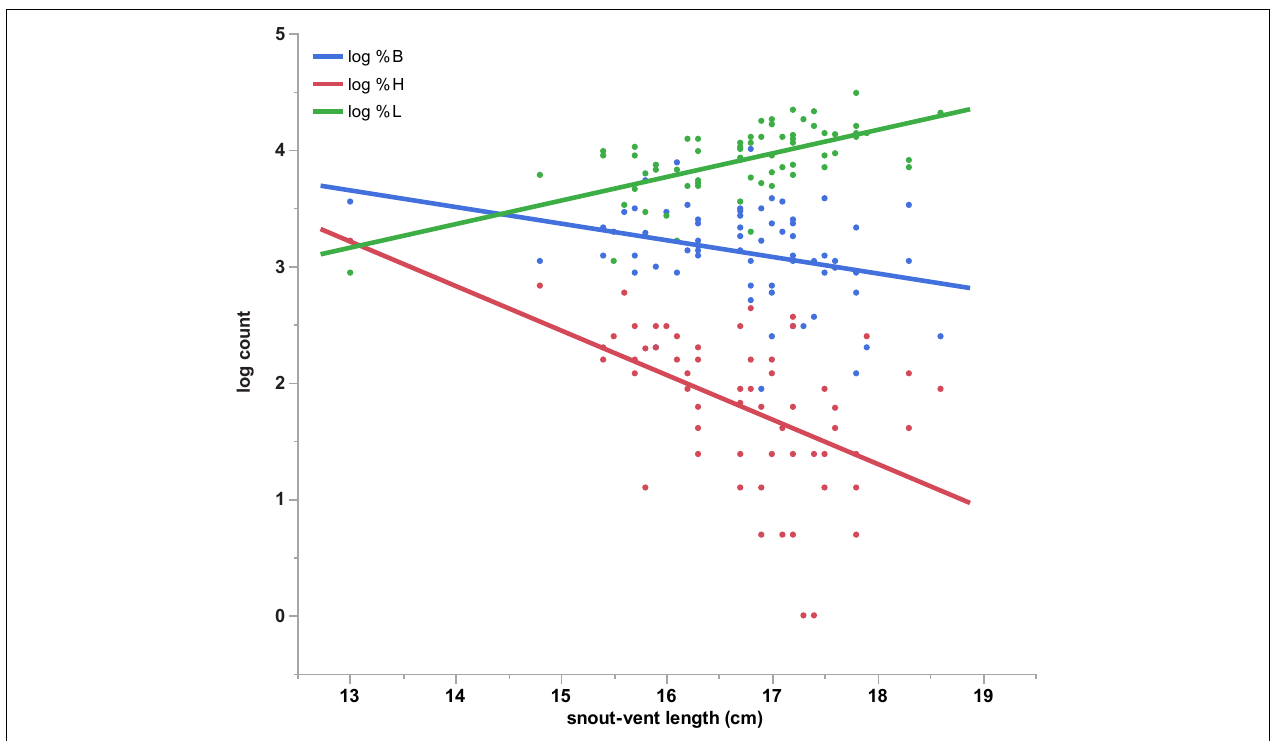
FIGURE 3 | Significant effects of hatchling body size of keelback snakes ( Tropidonophis mairii ) on white-blood-cell measures found in Experiment #1. Basophil and heterophil counts decreased with hatchling body size (SVL, snout-vent length) whereas lymphocyte counts increased with snout-vent length (SVL).